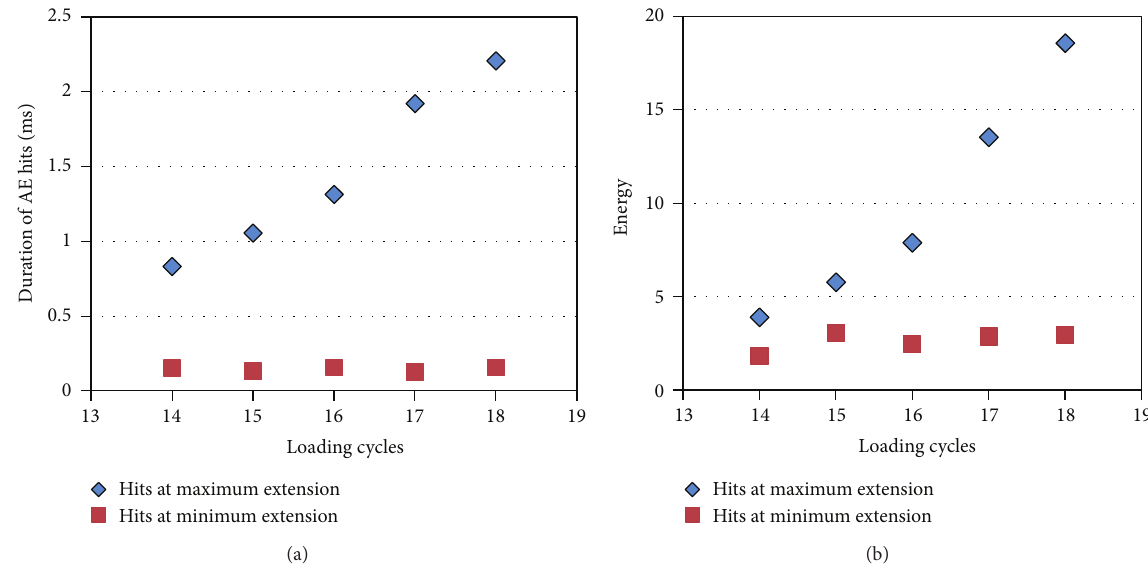
Figure 8: Average value of acoustic emission (a) duration and (b) energy at a time window of 6s around the maxima and minima of the strain cycles for specimen C.